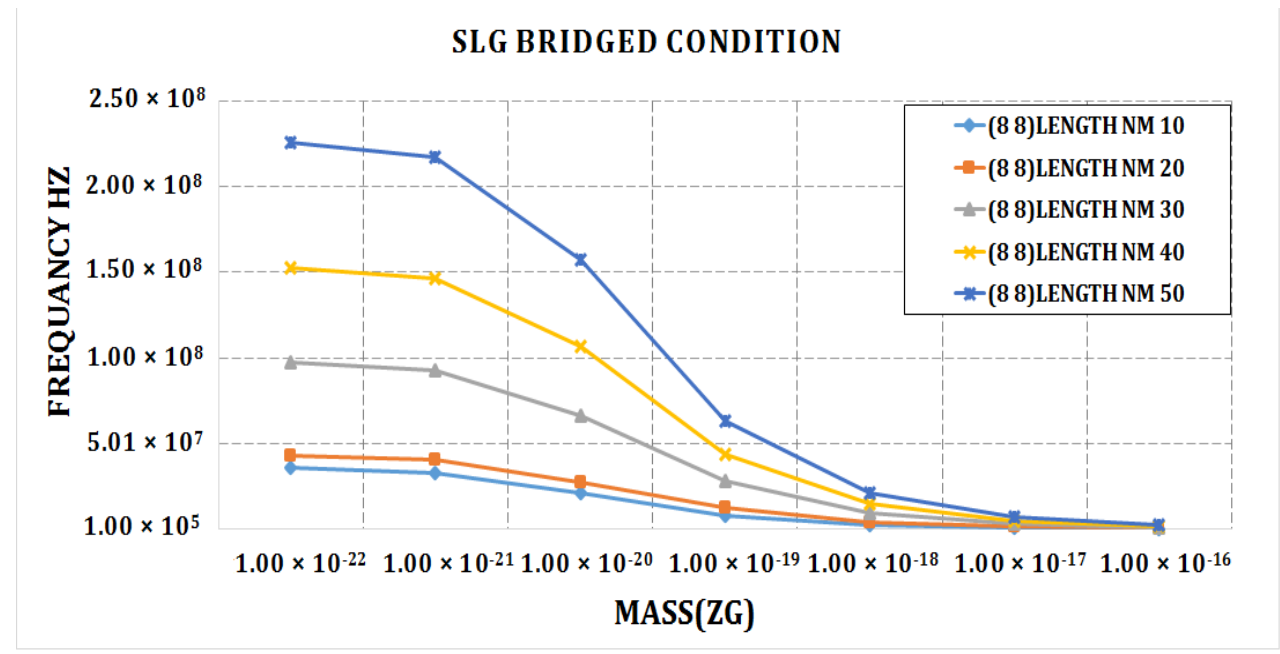
Figure 13. Frequency vs. mass graph for bridged armchair SLG (8, 8).